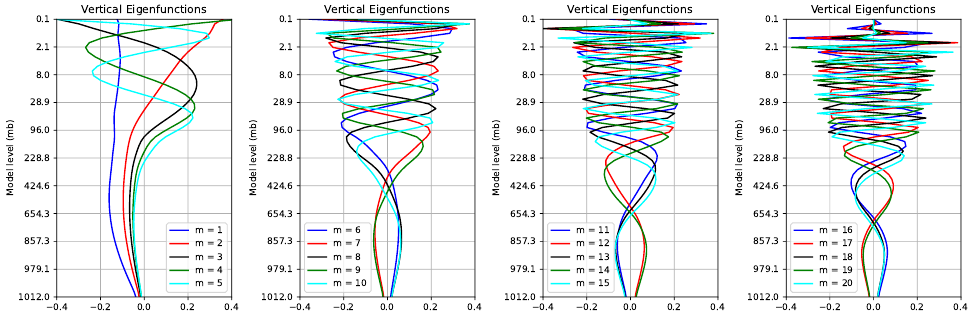
Figure 1. Vertical structure functions corresponding to the first twenty vertical modes of the normal mode